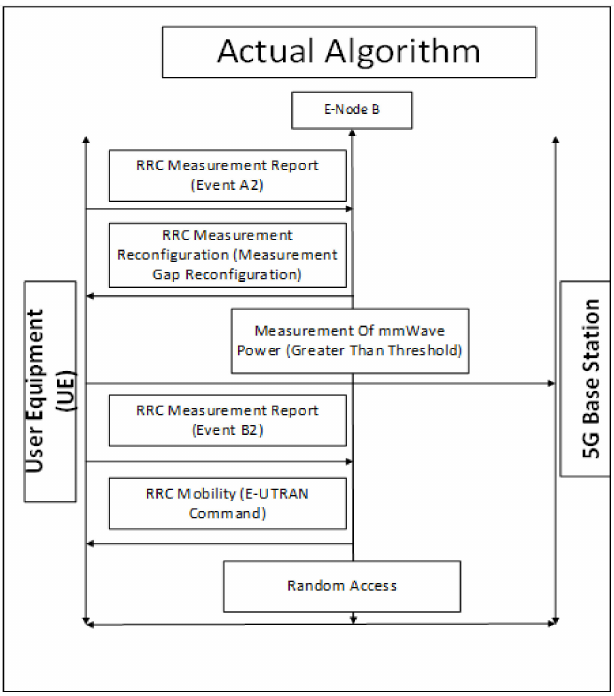
Figure 1. Actual algorithm for